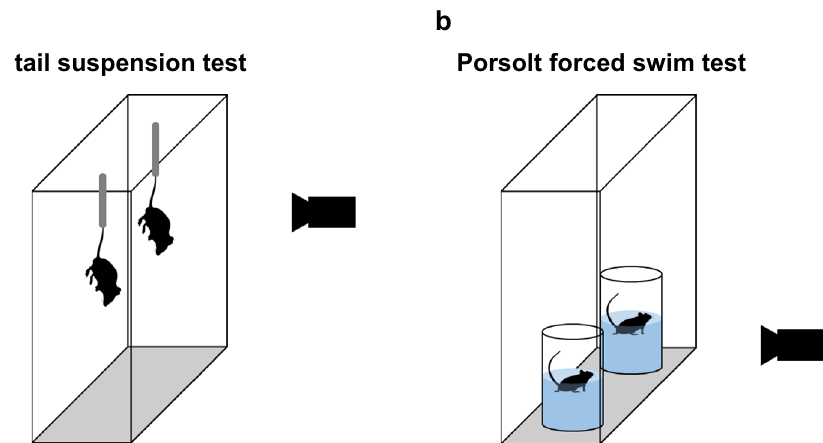
Figure 1. Schematic illustration of the experimental apparatus. ( a) Tail suspension test. ( b ) Porsolt forced swim mouse from here. The cylinders were filled with water (23 °C) to a depth of 7.5 cm, based on previous studies 20,21 . The mice were placed in the cylinders for 6 min and video recorded. The behaviour of the mice was analysed to determine the following parameters: the number of immobility episodes and the total duration of immobil- ity. The amount of time that each mouse remained immobile was recorded in seconds and then expressed as a percentage of the total time or as a percentage per minute. In this test, the ‘immobile period’ was defined as the period when the animals stopped struggling for ≥ 1 s. Data acquisition and analysis were performed using the ANY-MAZE software (Stoelting Co., Ltd.). Three patterns were used to assess whether the behaviour of the test mice was influenced by the experimental conditions, in the same way as for the tail suspension test (Fig. 3a). Effect of the demonstrator in the Porsolt forced swim test.